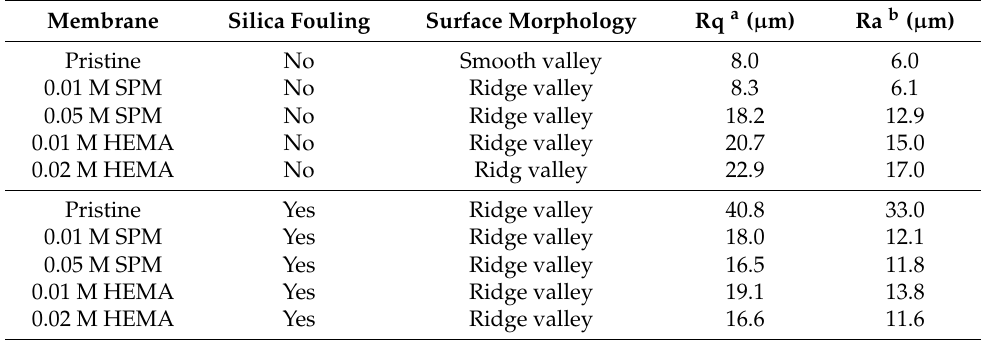
Figure 3. SEM pictures of the pristine and modified NF90 before ( a ) and after ( b ) silica fouling and 3D images of the pristine and modified NF90 before ( c ) and after ( d ) silica fouling. The SEM pictures marked with * were cited from our previous work [25]. Table 1. Surface characteristics of the pristine and modified NF90 before and after silica